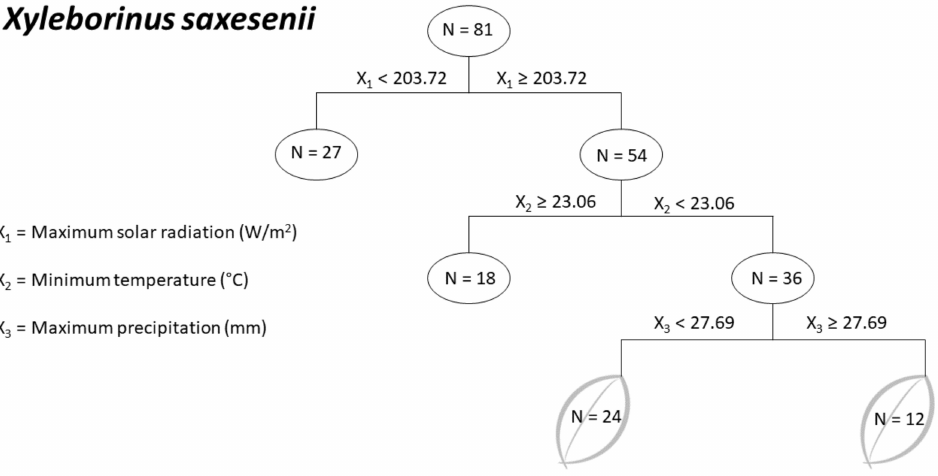
Figure 5. Decision tree schematic for Xyleborinus saxesenii abundance using weather conditions as explanatory variables.